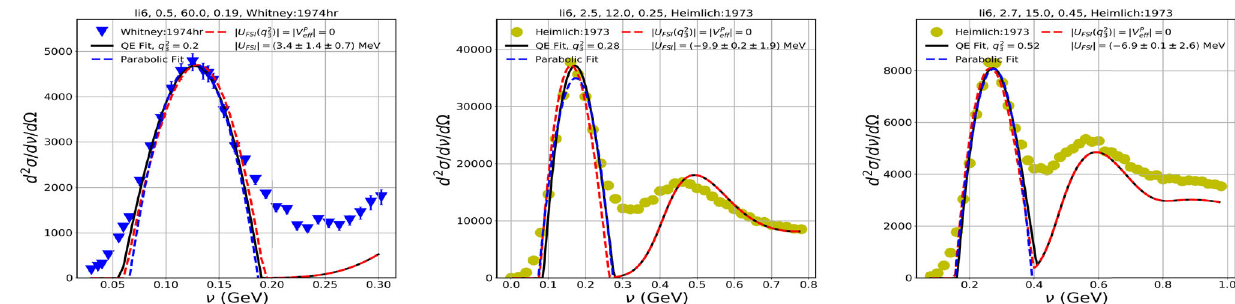
= 0 . 169 GeV) Li ( k P RFG model with U FSI = V ef f = 0. Above each panel we show: The F 3 element, E 0 in GeV, θ in degrees, Q 2 in GeV 2 , First Author, and year